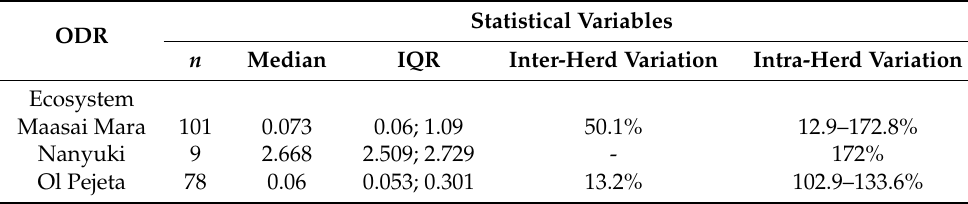
Table 2. Antibodies to CCHFV in serum in cattle in Kenya. Median and interquartile range (IQR) of optical density ratio (ODR) are presented. Variations were examined with coefficient of variation from individuals of the same herd (intra-herd variation; minimum and maximum are presented) or among herds (inter-herd